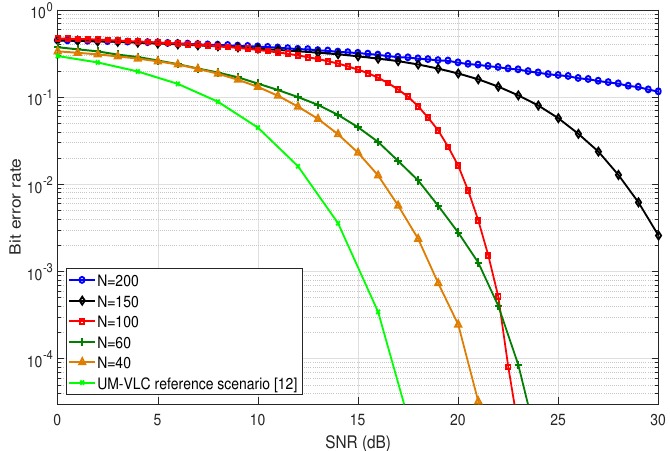
Figure 8. BER curves for different values of N in the hemispheric area of the evaluated UM-VLC scenario and the UM-VLC reference scenario, Reprinted from ref.